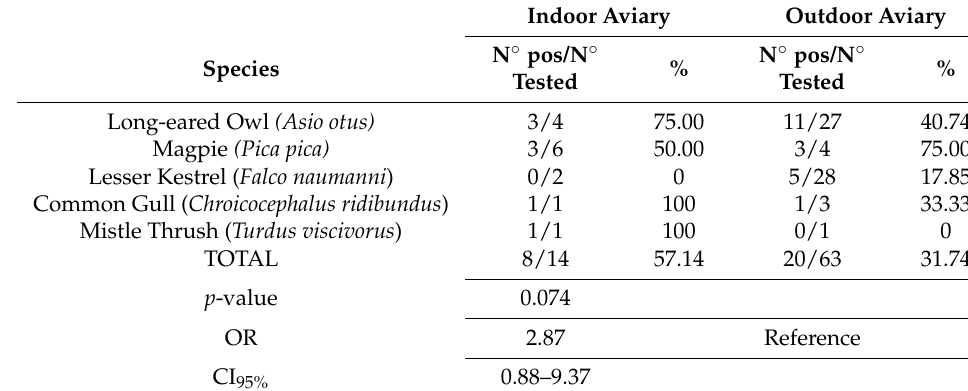
Table 5. Detection of Campylobacter in wild birds in external or internal